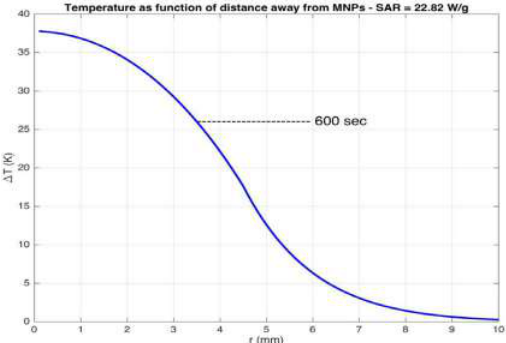
Fig 6. Temperature as a function of distance, thermodynamic equations predict the temperature drop as we get away from the center of the hyperthermic action.